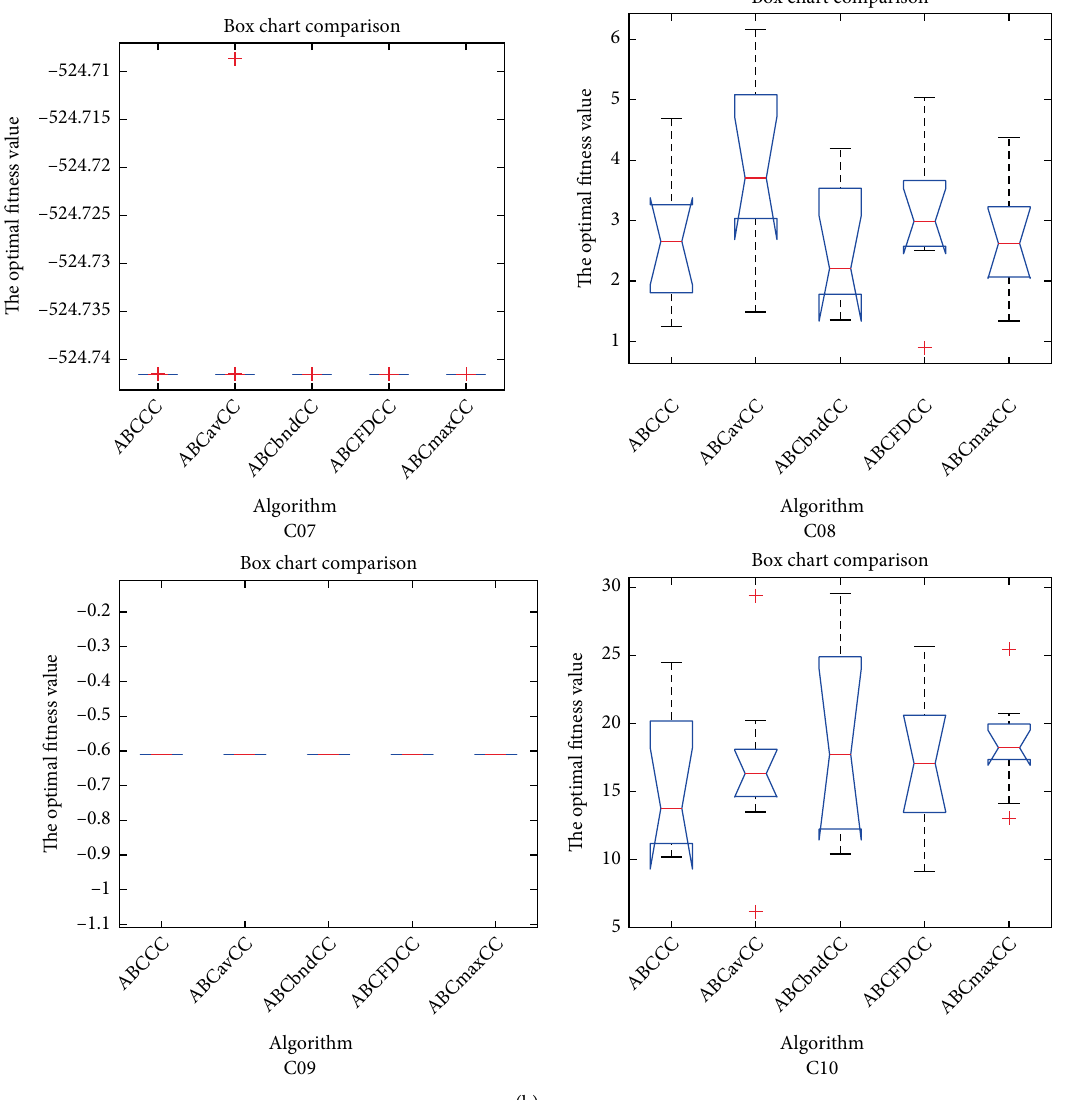
Figure 5: Box plot comparison results of the algorithm and its variants (10-